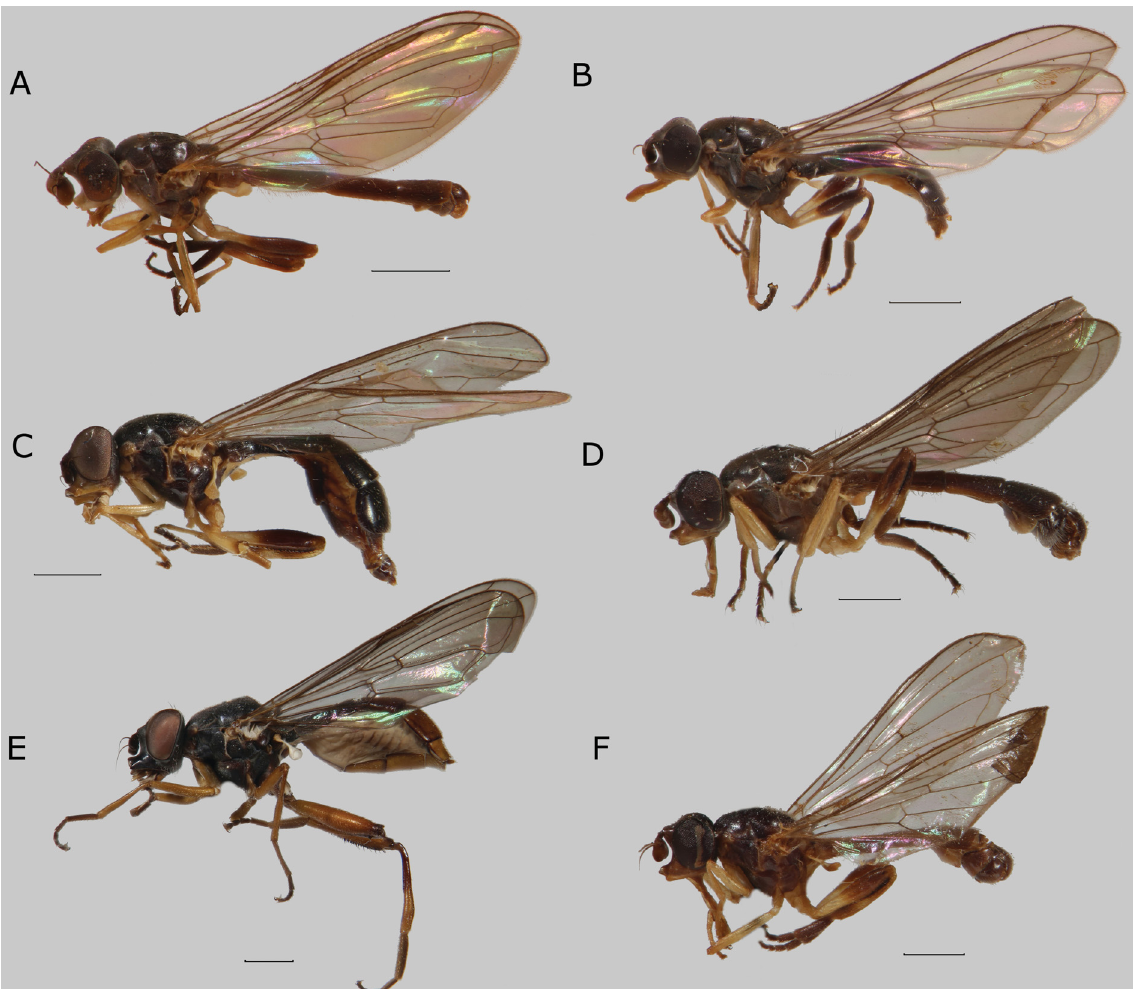
Fig. 2. Habitus, lateral view. A . Sphegina ( Sphegina) angustata sp. nov., paratype, ♂ ,